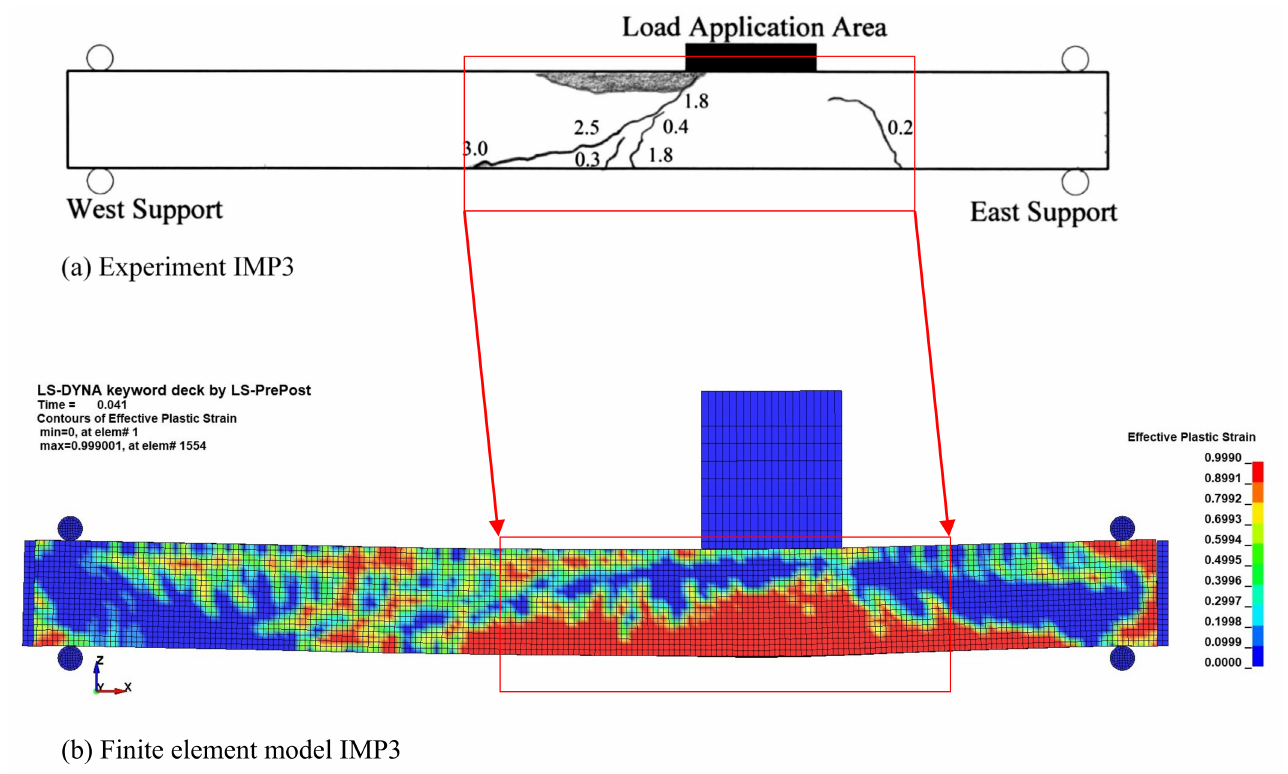
Figure 4. Damage pattern of the axially loaded RC column after impact.